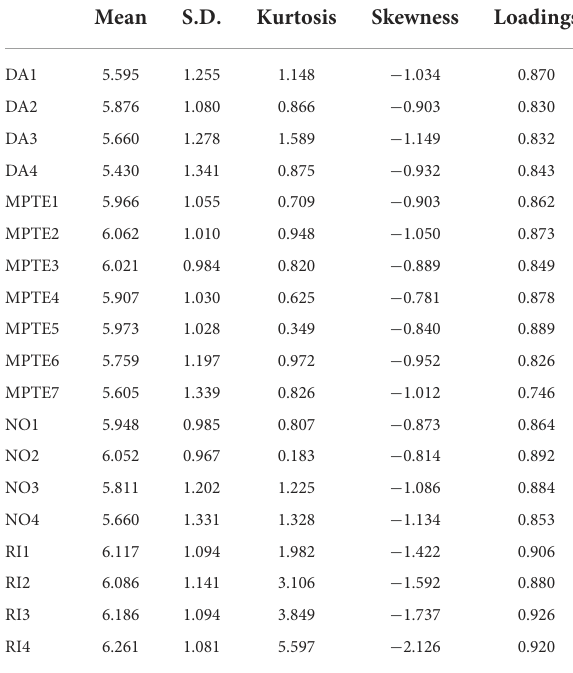
TABLE 2 Sample profile ( n = 291). TABLE 3 Descriptive statistics and factor